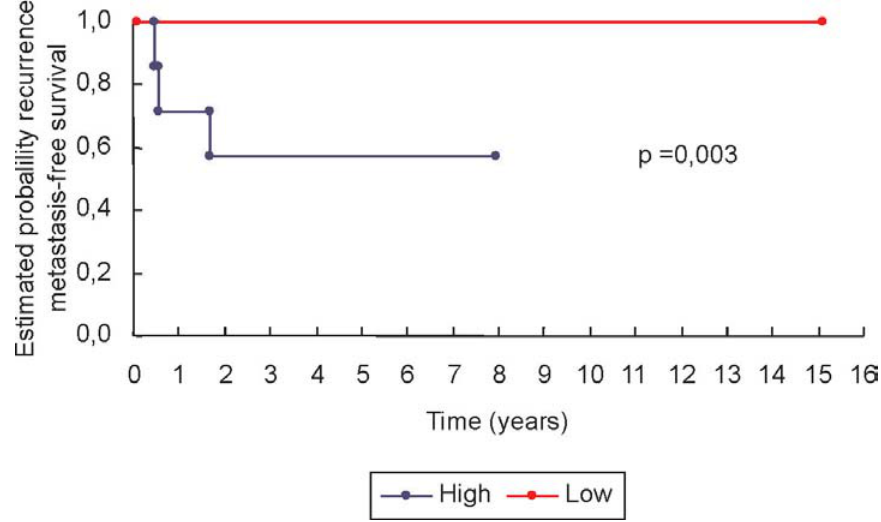
Figure 2 - Curve depicting metastasis-free survival (years) for the 25 patients with liposarcoma of the extremities according to the histological grade